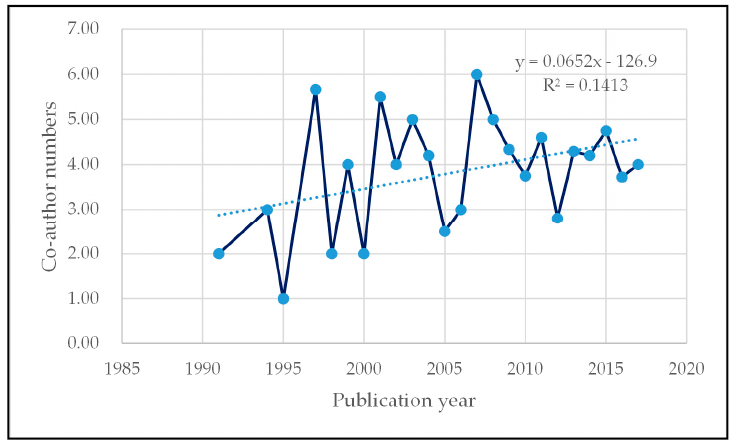
Figure 2. Average number of co-authors for each paper during the time.